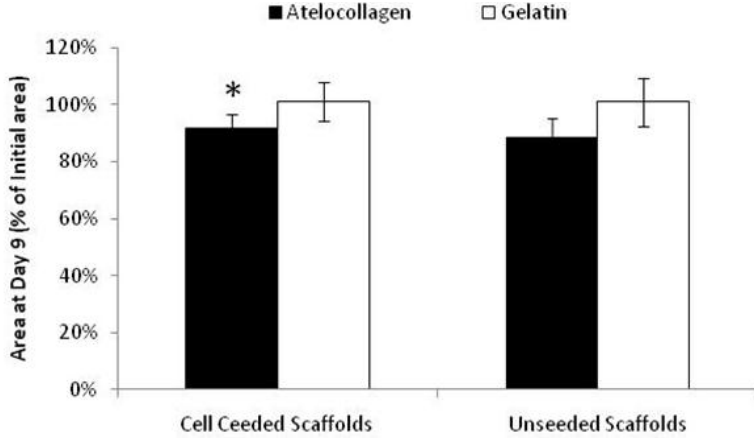
Figure 4. Contraction of scaffolds cultured for 9 days measured as a percentage of initial area. The atelocollagen scaffolds had a greater reduction in surface area than the gelatin scaffolds. A similar trend was seen for cell seeded scaffolds, and non-cell seeded scaffolds. * denotes significantly greater contraction of the cell seeded atelocollagen scaffold compared to the cell seeded gelatin scaffold (p <